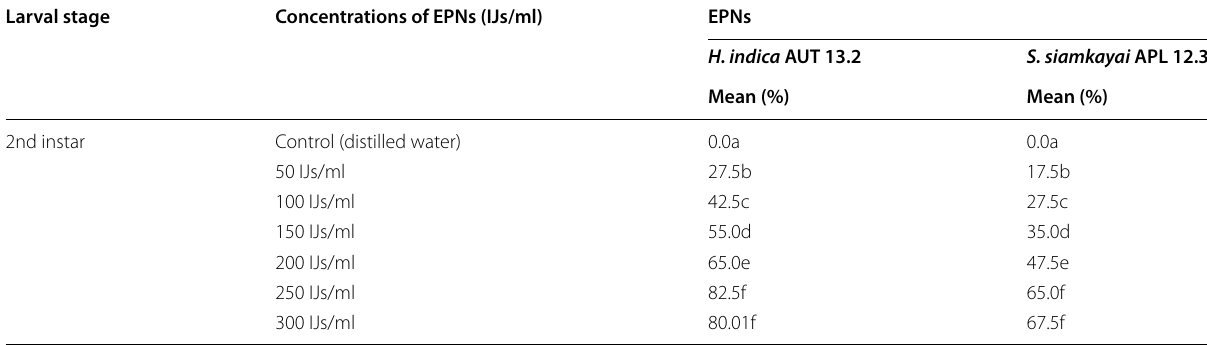
Table 1 The mean of accumulated mortality percentage of the 2nd instar larvae of FAW at 10 days after application of the EPNs Heterorhabditis indica isolate AUT 13.2 and Steinernema siamkayai isolate APL12.3 in the laboratory condition Larval stage